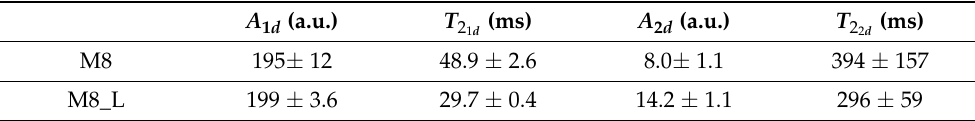
Table 1. Average values of the A and T 2 parameters as measured across the hydrogel wound